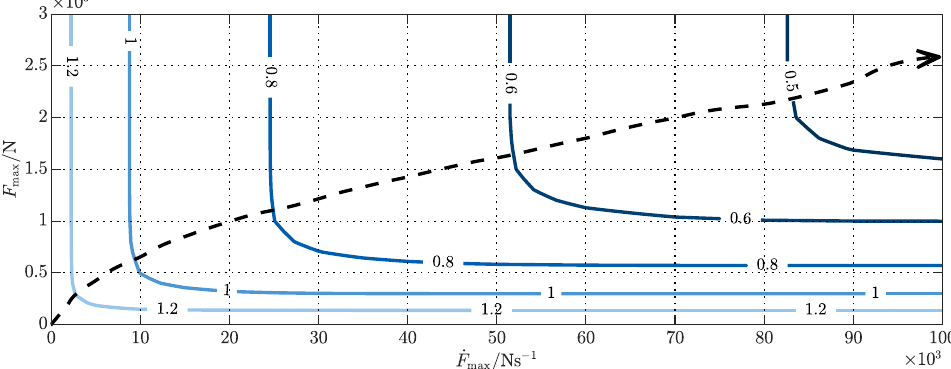
Figure 15. RMS body acceleration contour plot for the 180kmh − 1 AB profile